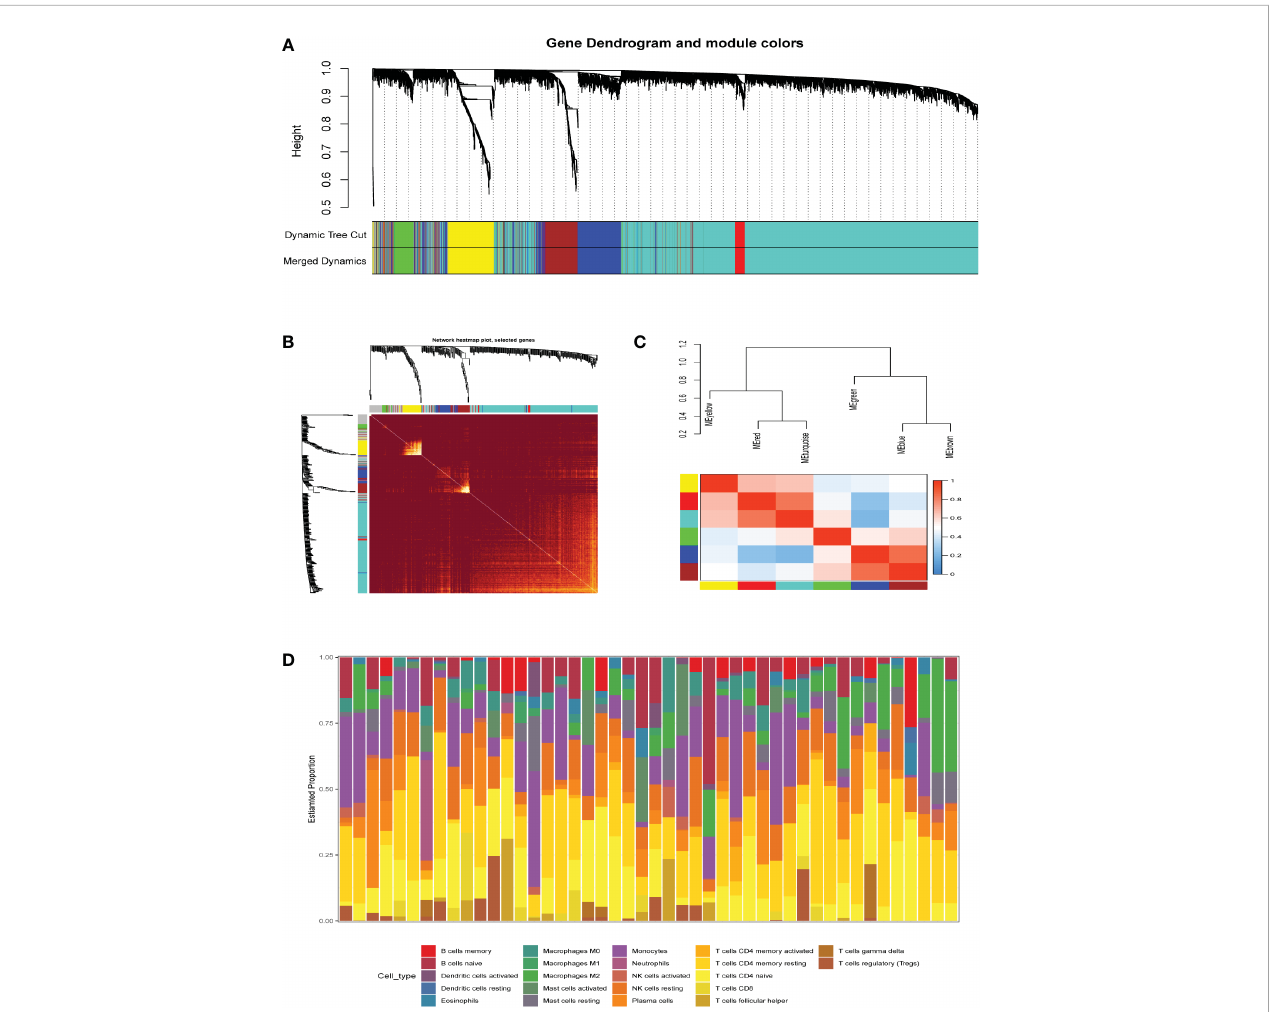
FIGURE 2 (A) Clusteringdendrogram ofgenes, with dissimilarity basedontopological overlap, together with assigned merged modulecolorsand the originalmodule colors. (B) The heat map depicts the topological overlap matrix (TOM) ofall genes in the analysis. Gene dendrogramsand module assignmentsare also shown onthe leftand top. (C) Genes areclassi fi ed into different modules by hierarchical clustering, different colors below the hierarchicalclusteringtree represent different modules. (D) Correlationheatmap ofin fi ltration ofimmune cells in normal and AKI renal